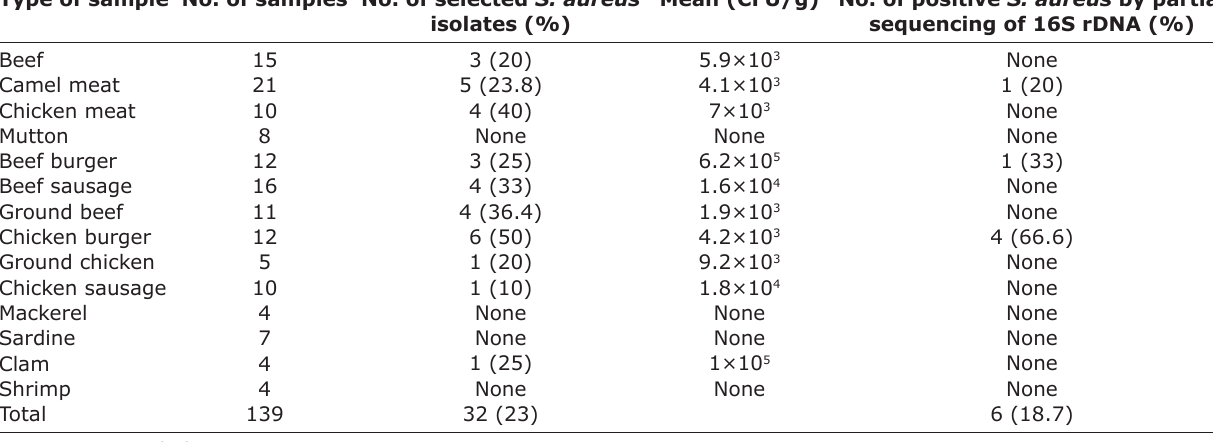
Table-2: Incidence of selected S. aureus isolated from meat, meat products, and some seafood samples on Baird-Parker medium. Type of sample No. of samples No. of selected S. aureus Mean (CFU/g) No. of positive S. aureus by partial sequencing of 16S rDNA isolates (%)